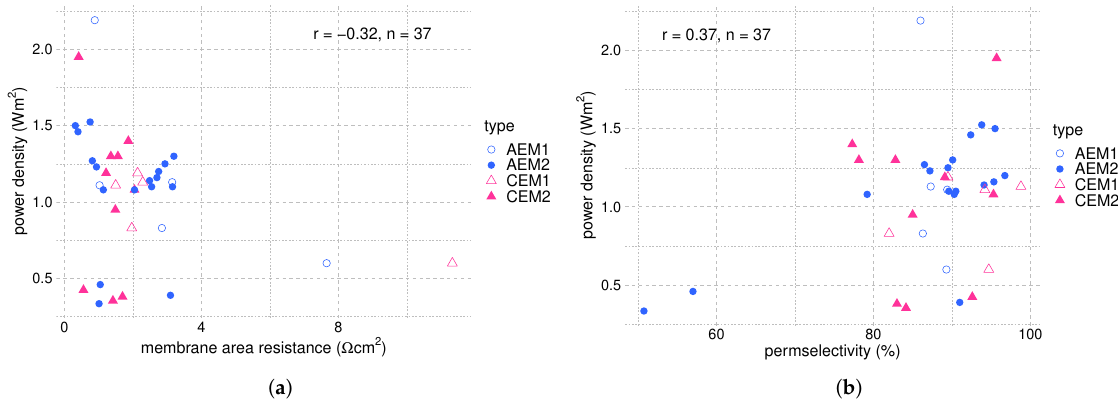
Figure 6. Power density plotted against membrane area resistance and permselectivity for a concentration difference of NaCl of 0.48 to 0.49 M between the HC and LC streams. Data are extracted from Tables 2 and 3. Additional data concerning commercial membranes have been collected from [92,93,112]. A total of 42 observations form the basis of the analysis, with seven observations of commercial AEMs (AEM1), 18 of tailor-made AEMs (AEM2), 7 of commercial CEMs (CEM1), and 10 of tailor-made CEMs (CEM2). The Pearson coefficient r indicates the correlation between the two plotted variables, and n refers to the number of observations used for each plot. ( a ) power density vs. membrane